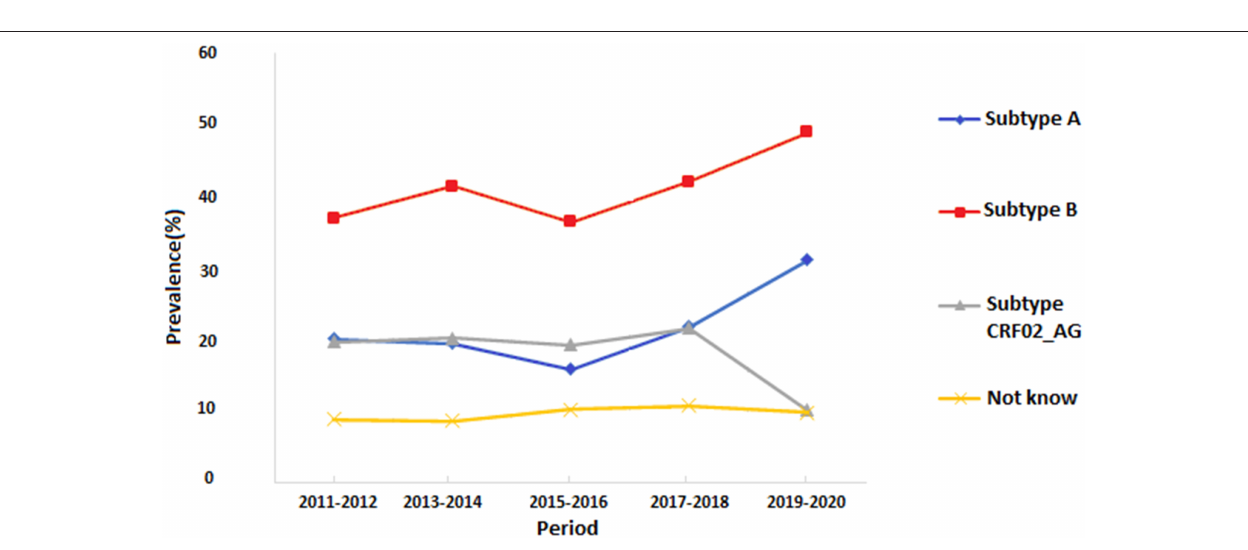
FIGURE 2 | The regional prevalence of HIV and geographic distribution of HIV-1 subtypes during the Libyan conflict (A) the period from 2011 to 2015; (B) period from 2016 to 2020.